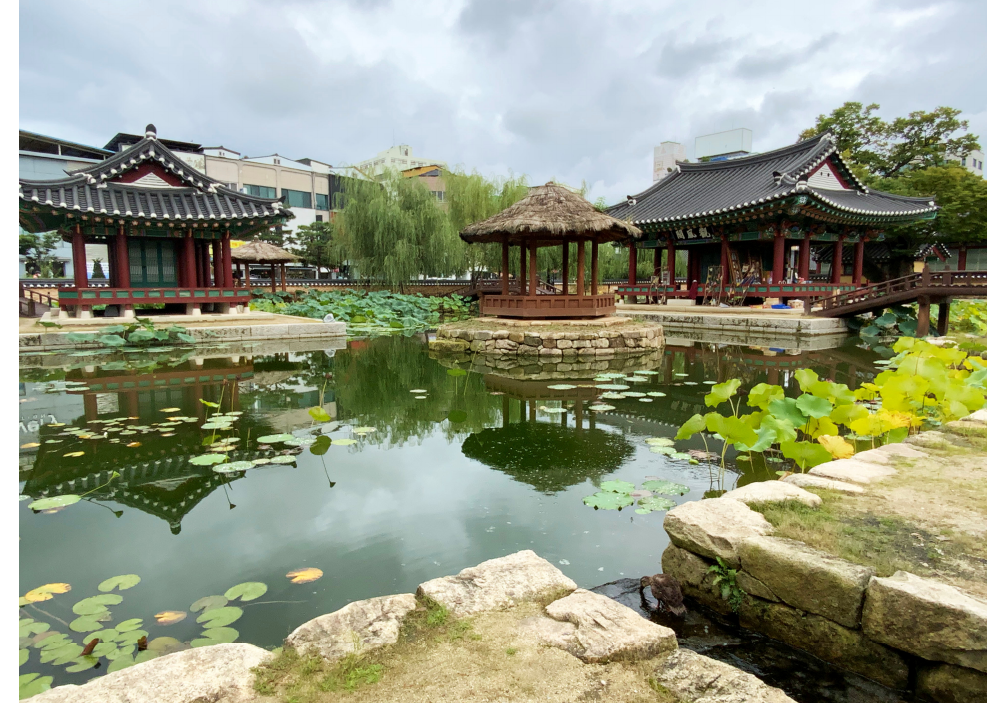
Figure 13. Back Garden of Kangwŏn Provincial Office. Late Chosŏn Dynasty, modern reconstruction based on archaeological excavations. Buildings from left to right: Pongnae/Penglai Pavilion, Pavilion for Terrapin Catch (thatched; behind Pongnae Pavilion), Gathering Medicinal Herbs Dock (thatched round structure), and Yŏngju/Yingzhou Pavilion. Inlet on lower right of picture. Wŏnju, Kangwŏn Province. Photograph by author.